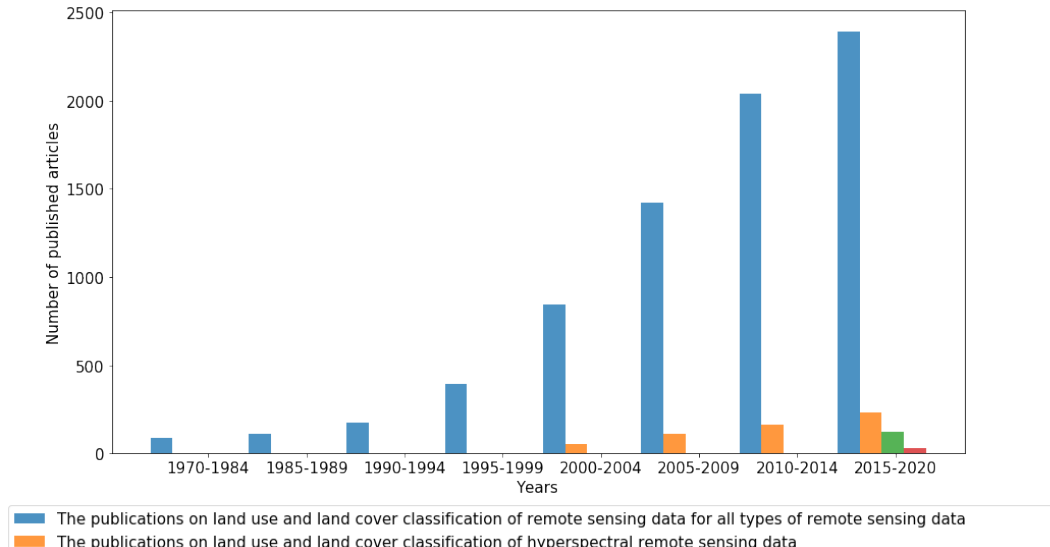
Figure 2. The publication trends over LULC classification of remote sensing data. The graph shows a consistent increase in the number of publications. The graph also shows the portion of publications dedicated to hyperspectral images classification and the use of deep learning techniques (data were retrieved in May